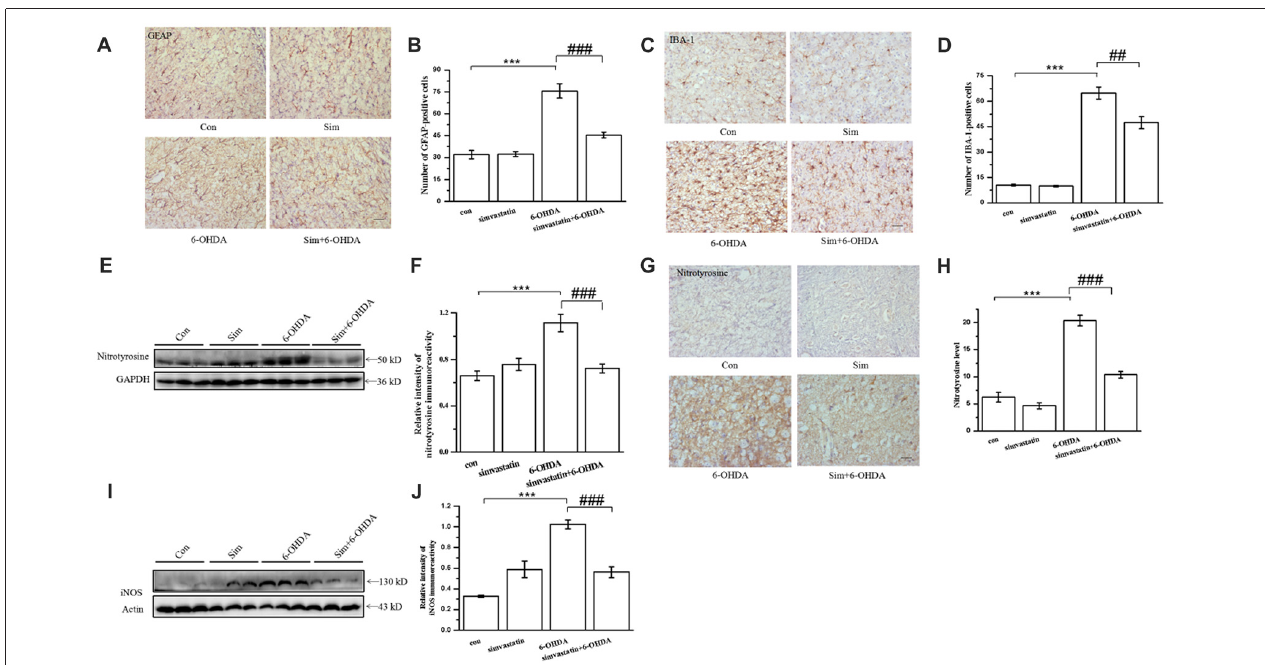
FIGURE 7 | Simvastatin inhibited gliosis and the level of tyrosine nitration in midbrain samples in the unilaterally 6-OHDA-lesioned mouse model of PD. On day 15 after 6-OHDA stereotaxic injection, brain sections were prepared, incubated with glial fibrillary acidic protein (GFAP) antibody (A) , ionized calcium-binding adapter molecule 1 (IBA-1) antibody (C) , and HRP-conjugated secondary antibody, and then visualized with DAB. Relative quantitative analysis of GFAP-positive cells (astrocyte) (B) and IBA-1-positive cells (microglia) (D) . Data were obtained from at least three independent experiments. (E) Protein was extracted from midbrain tissues, and the level of nitrotyrosine was evaluated by western blot. (F) Relative quantitative analysis of nitrotyrosine expression. Data were obtained from four independent experiments. (G) Immunostaining of nitrotyrosine in the substantia nigra (SN); (H) immunoreactivity of nitrotyrosine was analyzed and quantified using IPP 6.0. Scale bar, 30 µ m. (I) iNOS level evaluated by western blot. (J) Relative quantitative analysis of iNOS expression. Data were obtained from three independent experiments. Statistical analysis by Dunnett’s T3 or LSD post hoc test based on ANOVA; data expressed as mean ± SEM. ∗∗∗ P < 0.001, ## P < 0.01, ### P <